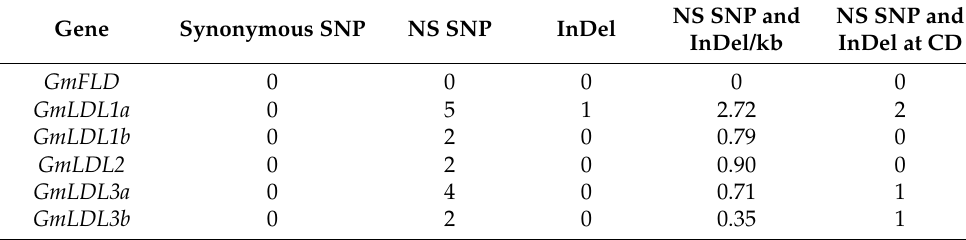
Table 1. The SNP and InDel summary of GmLDL genes within sequenced soybean